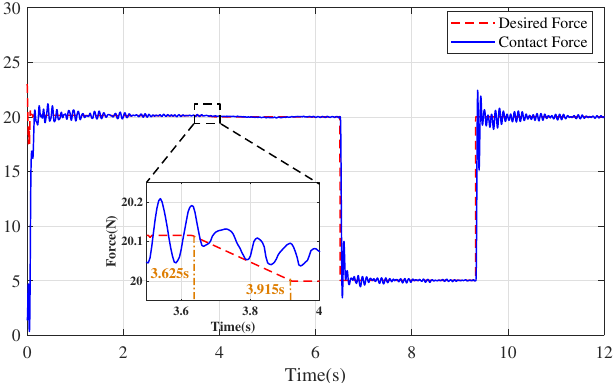
Figure 19. Impedance control with impedance matching when the polishing spindle does not rotate. This experiment represents the entire process of force control, from contact to stabi-